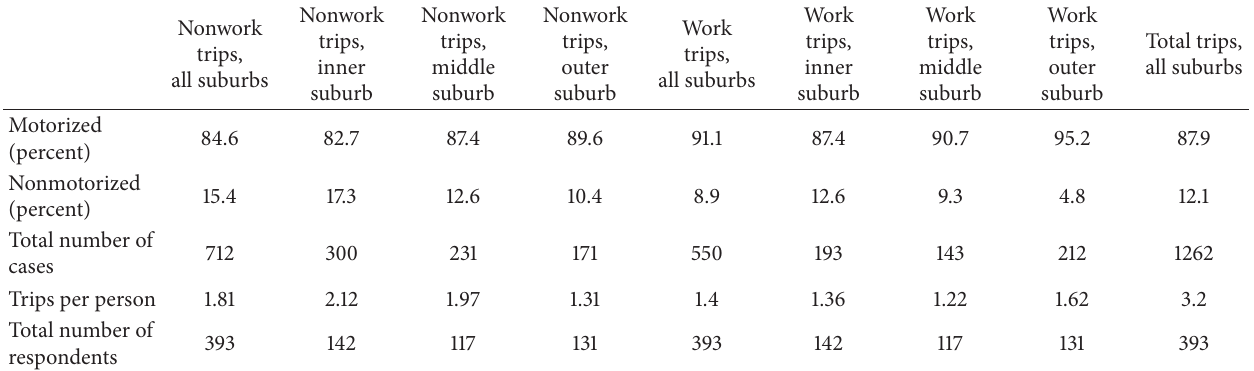
Table 2: The distribution of choice modes among the three case study